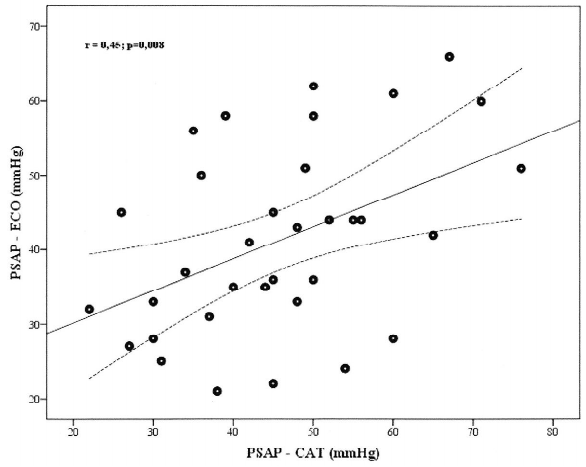
Fig. 1 - A correlação entre a eco-PSAP e o cat-PSAP no grupo dos